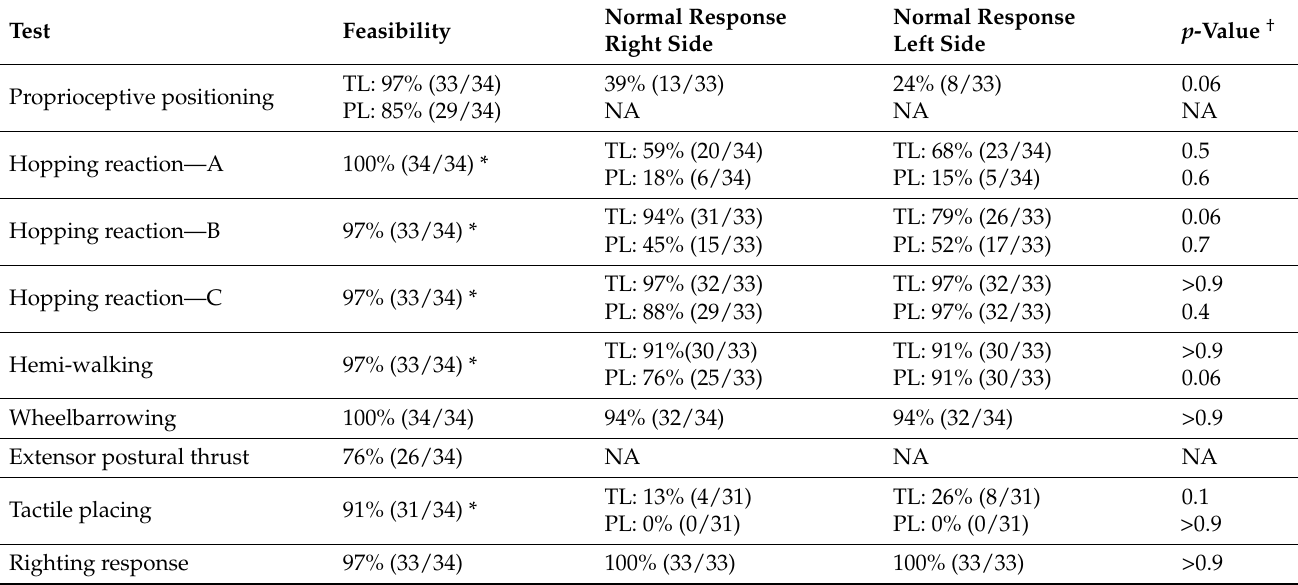
Table 2. The feasibility and normal response rate of individual postural reaction